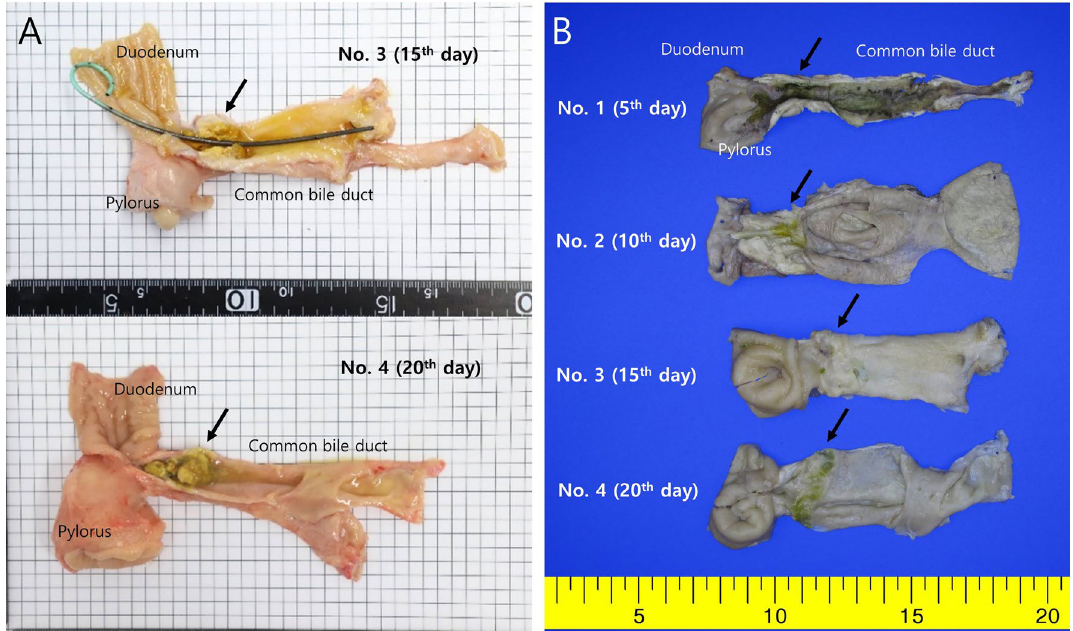
Figure 5. Histopathologic gross images of resected and longitudinally opened CBD. ( A ) Gross images of the common bile ducts, exposed immediately after excision. ( B ) Gross images of the common bile ducts